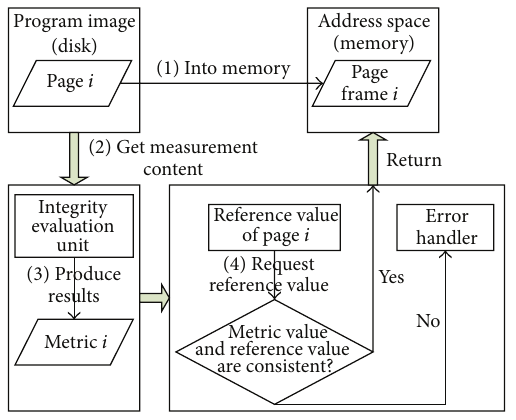
Figure 2: The dynamic measurement process of MP model.